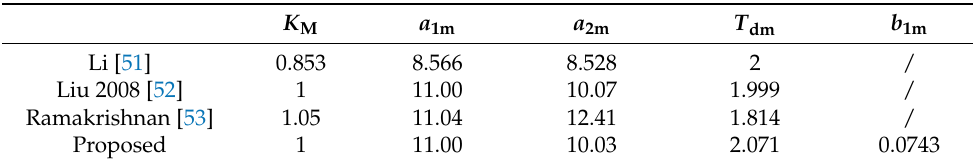
Table 10. The estimated model parameters for the process G P5 .